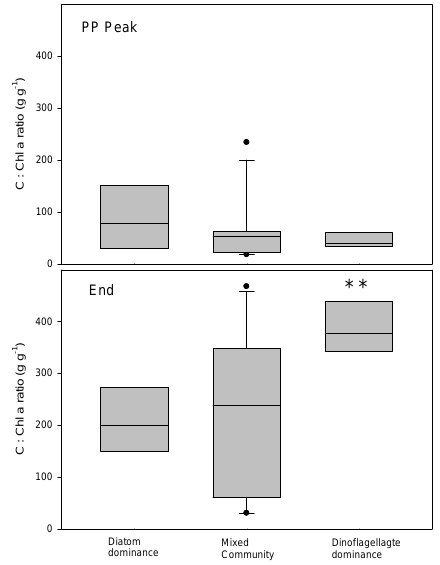
Figure 7. The C:Chl a ratio at the primary production peak (PP) and at the end of the experiment (end). The phytoplankton commu- nity was divided into three categories: diatom dominance (>80%), mixed community (20–70% dinoflagellates), and dinoflagellate dominance (>70%). The rationale behind setting the group bound- aries was based upon the apparent difference in species evenness (Fig. 2).